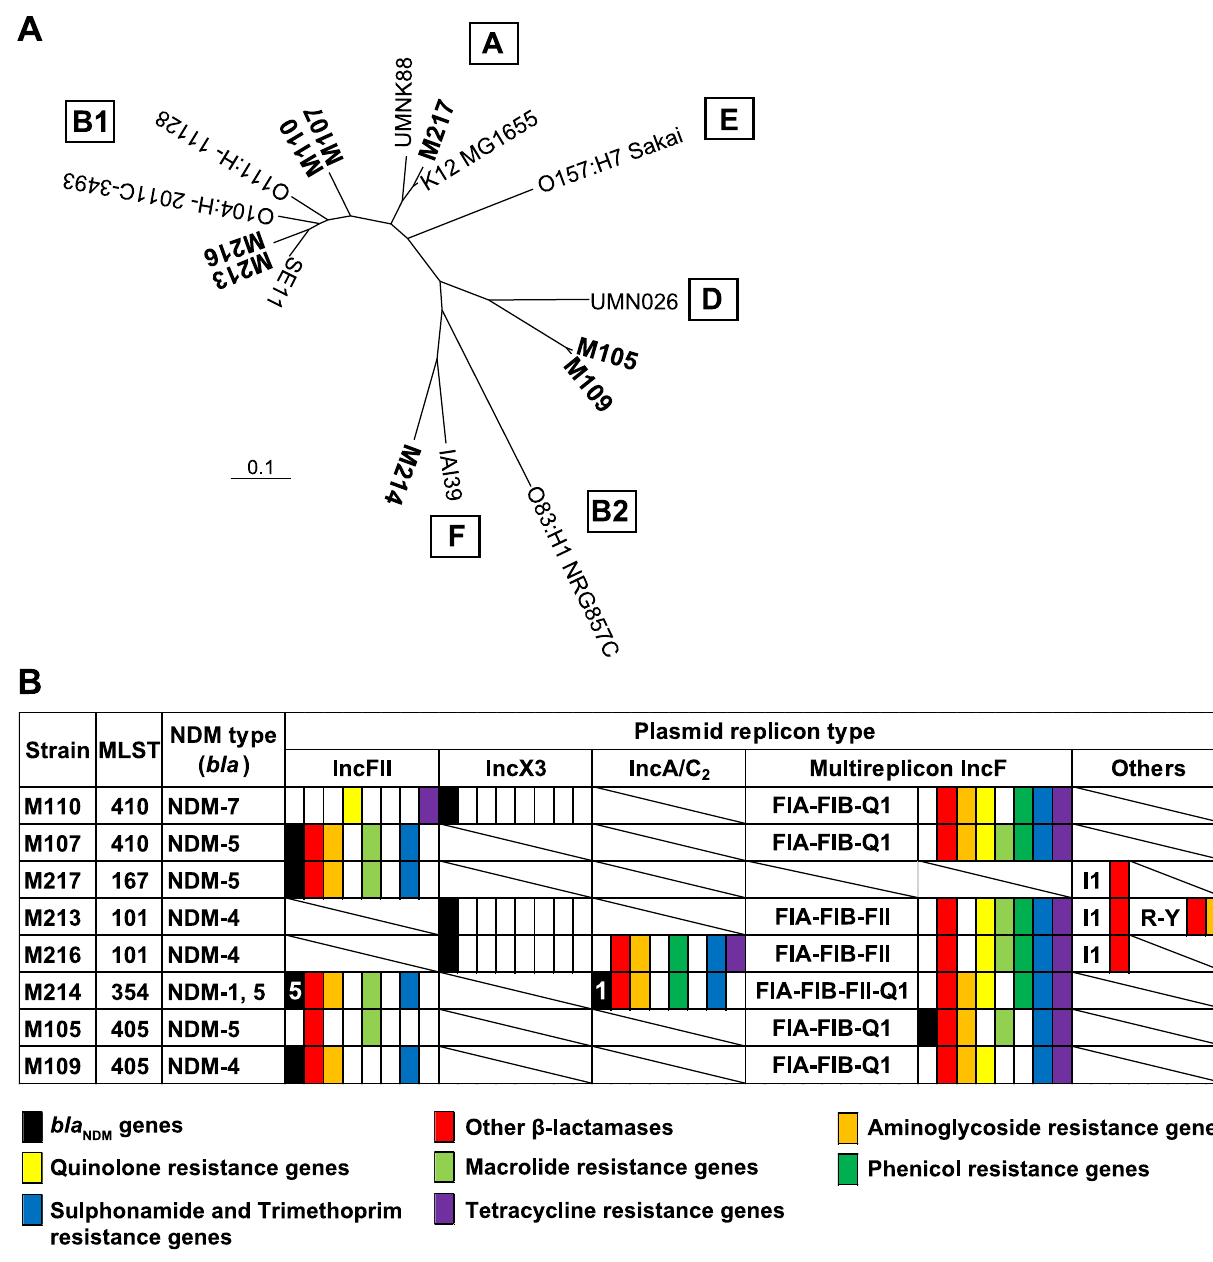
Fig 1. Phylogeny of carbapenem-resistant E . coli isolated in Myanmarand featuresof their bla NDM -harboring plasmids. (A) Phylogenetic tree of carbapenem-resistant E . coli isolates basedon WGS. Referencegenomesand severalother availablegenomeswere includedfor comparison. Phylogroupsof the reference strains are indicatedin boxes. (B) Multilocus-sequencetypes, NDM types, plasmid- replicon types, and antimicrobial-resistance profiles determinedby databasesearch. In strain M214, NDM types are indicatedby numberson black-shaded